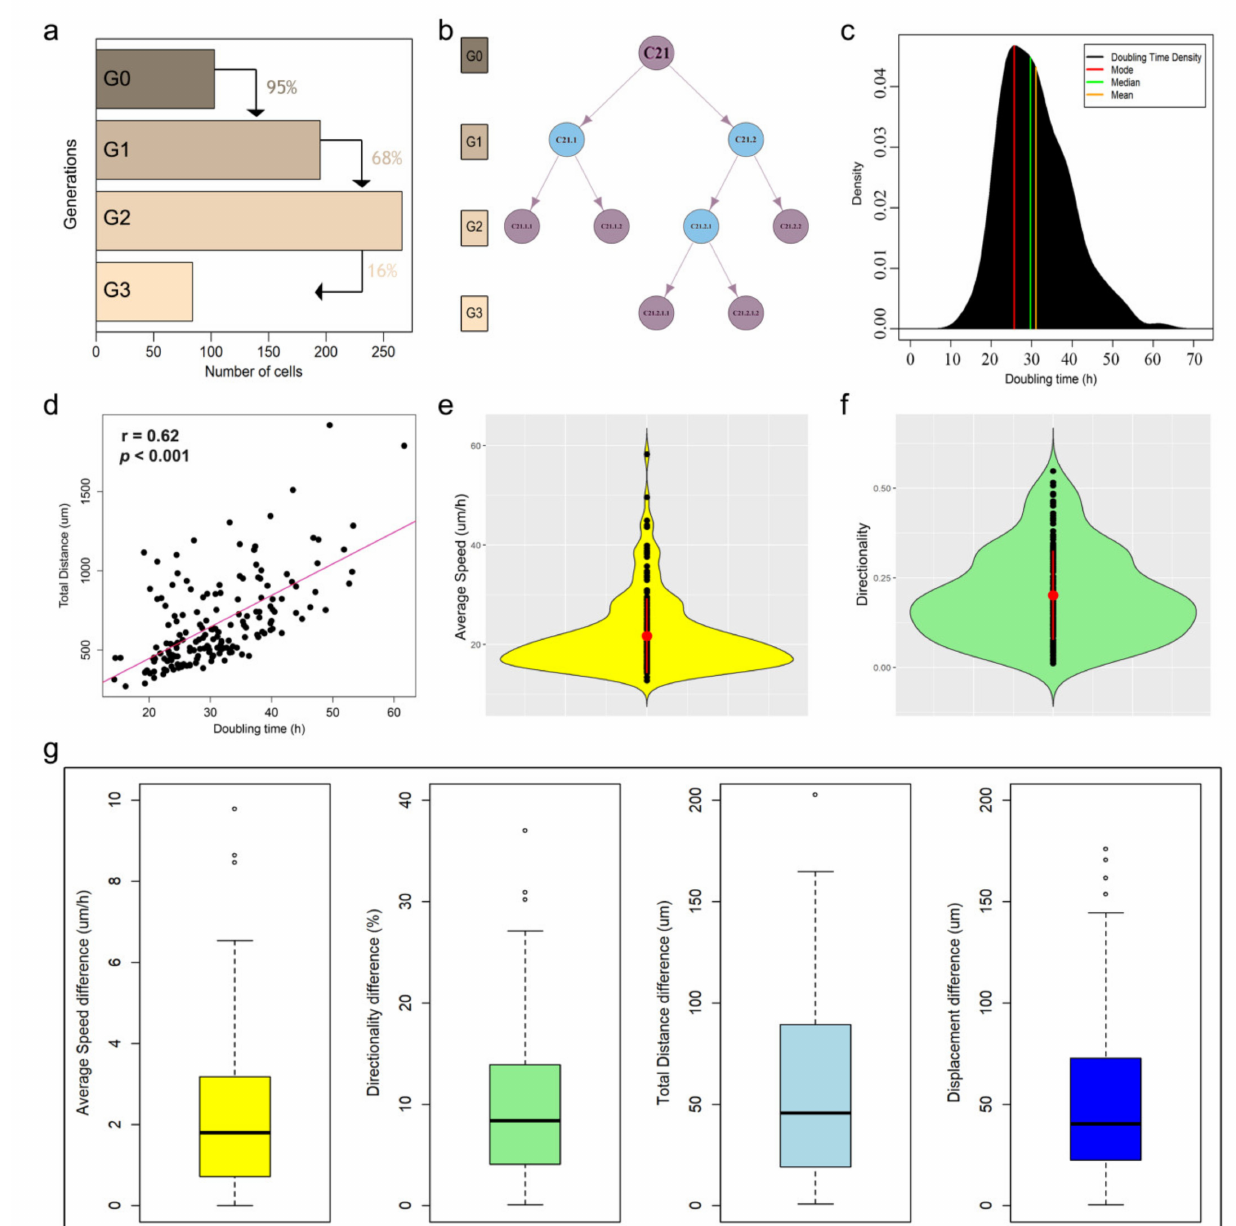
Figure 3. Characterizing the trajectory movement of BT549 cells. ( a ) Bar plot showing number of tracked cells per generation. ( b ) Lineage tree of cell #21 and its descendants; blue vertices refer to dividing daughter cells. ( c ) Density plot of the doubling time of BT549 cells ( n = 175). ( d ) Correlation between BT549 doubling time and total migration distance (Spearman’s rank correlation coefficient = 0.6). ( e , f ) Violin plots showing the median and the interquartile range of the average speed and directionality of BT549 cells. ( g ) Boxplots showing the heterogeneity among BT549 daughter cells ( n = 121 pairs) as a function of four migration parameters: total distance, displacement, directionality, and average